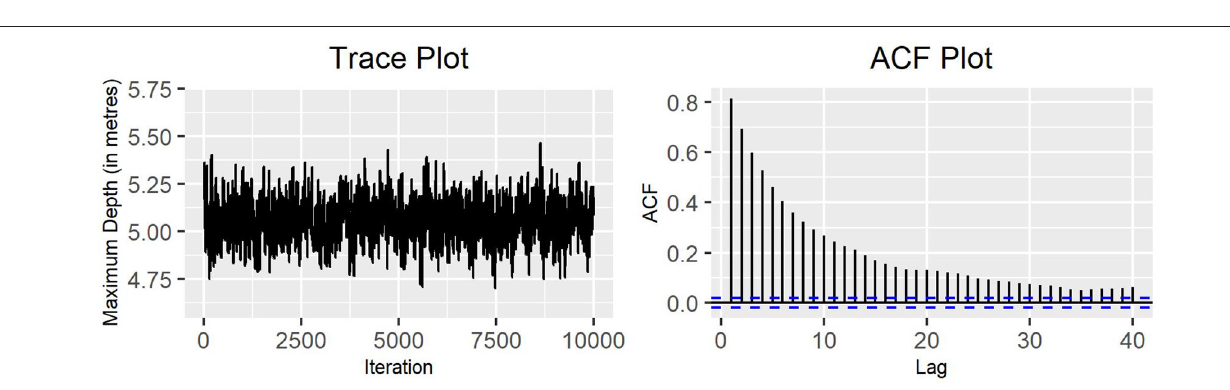
deviations δ of the RW every 100 iterations during burn-in and were then fixed for the RW updates of all the following